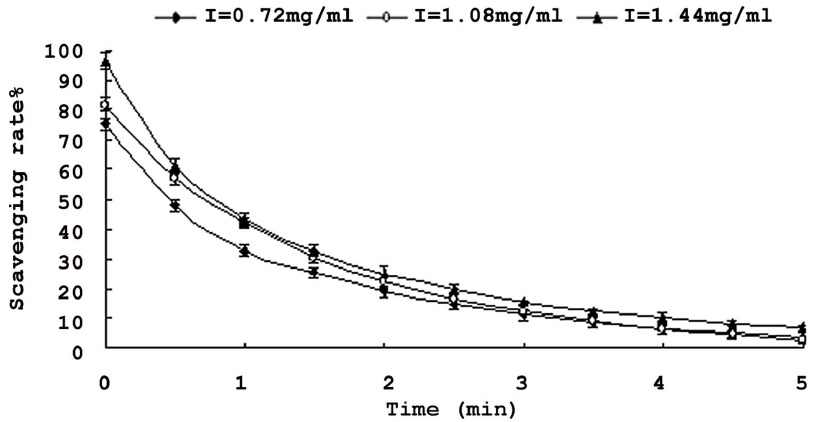
Figure 6. Scavenging effects of saponins from XanthocerasSorbifolia nutshell on super oxide radicals. Each value is expressed as mean ± standard deviation